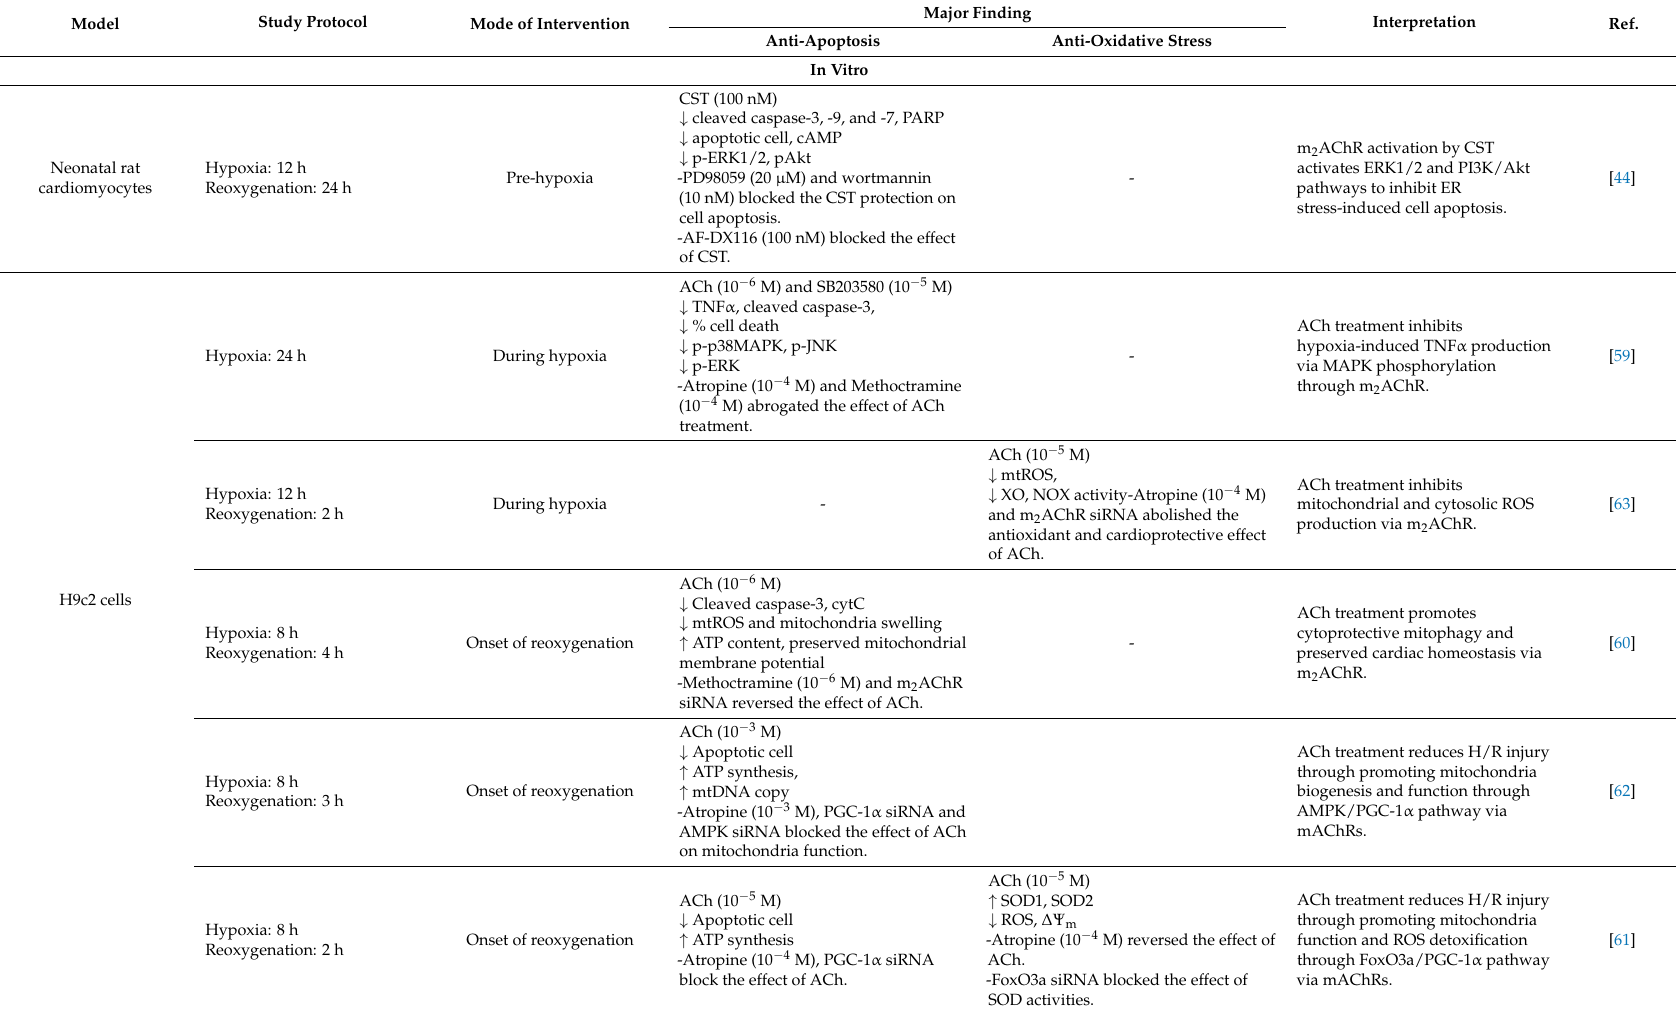
Table 3. Anti-apoptotic and anti-oxidative stress effects as a result of muscarinic acetylcholine receptor activation against ischemia/reperfusion-induced cell injury.